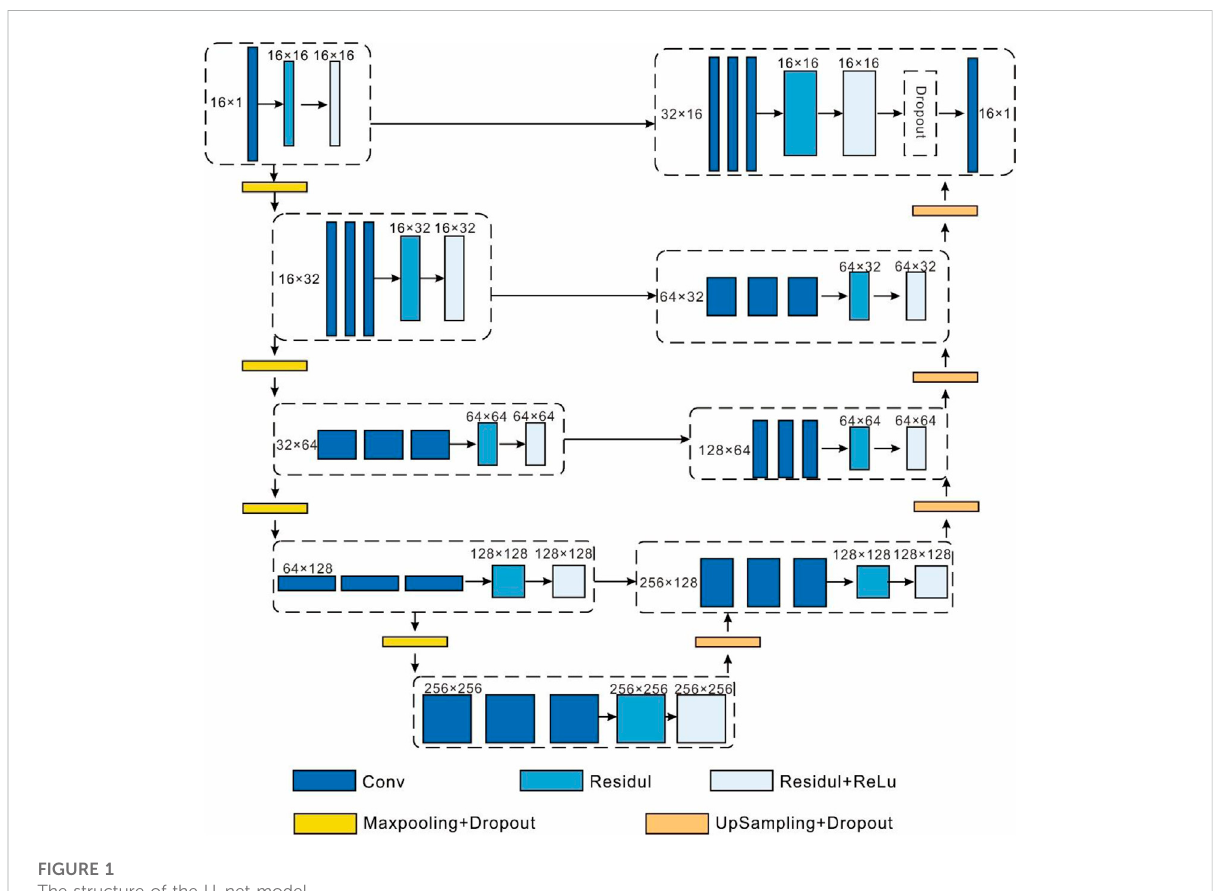
FIGURE 1 The structure of the U-net